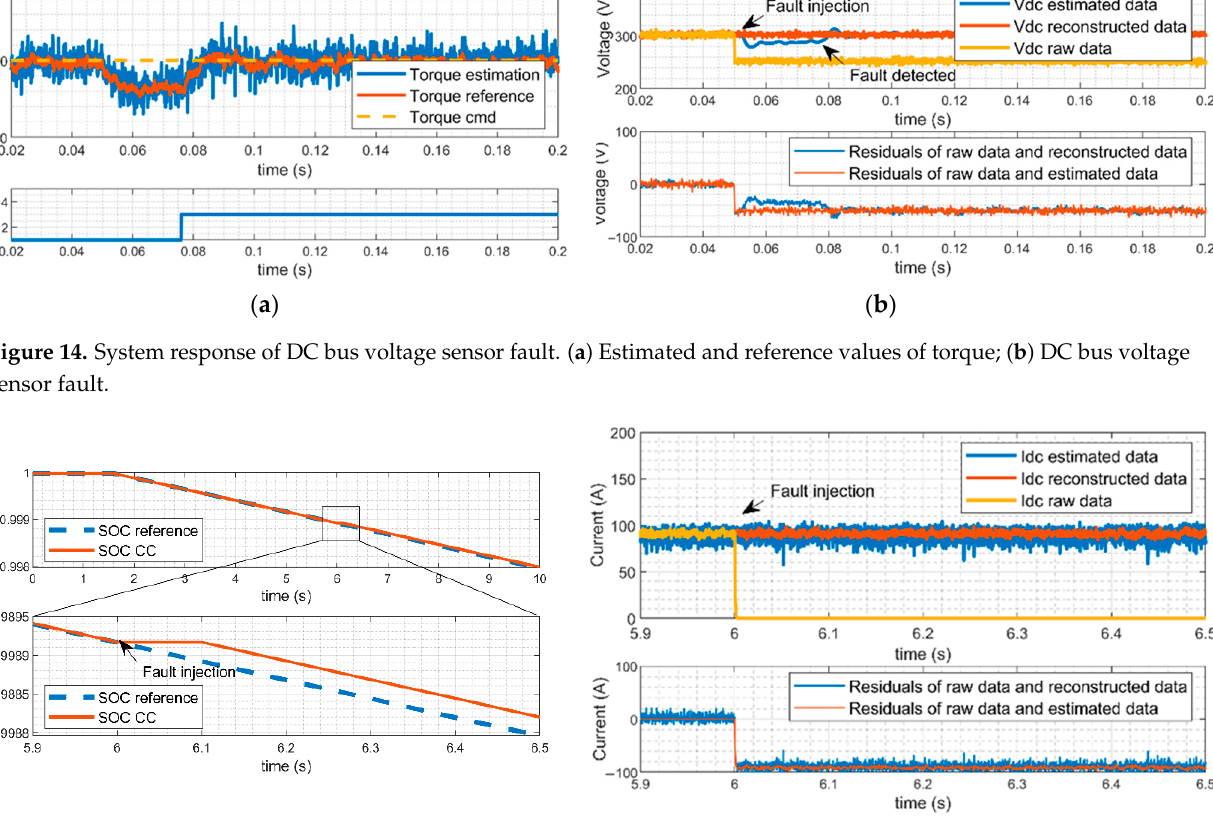
( b ) Figure 13. System response of phase A current sensor fault. ( a ) Estimated and reference values of torque; ( b ) phase A current signal and its residual. 4.4.2. DC Bus Voltage Sensor Fault The torque output of motor is determined by current, the abnormality of voltage sen- sor does not directly affect the power output in most cases. However, in order to suppress the DC bus voltage ripple, the controller will acquire the dq axis command and then uses the voltage signal for compensation, which causes the torque command to be inconsistent with the output torque when the voltage sensor is abnormal. As shown in Figure 14, when